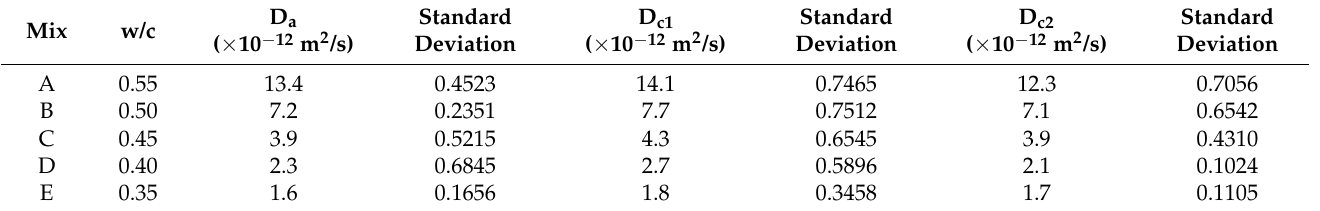
Figure 8. Chloride diffusion coefficient with different determination methods.